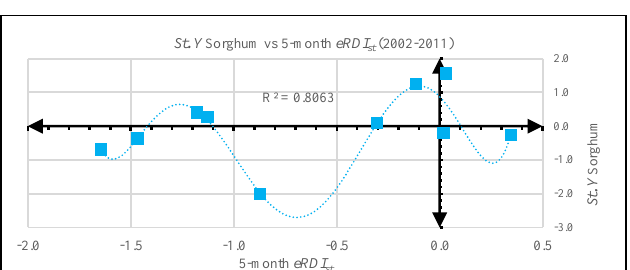
Figure 5: St. Y Maize vs 5-month eRDIst .